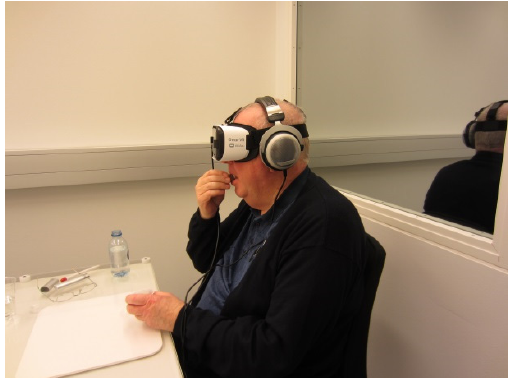
Figure 2. Photo of a participant tasting rye bread during VR contextual exposure.